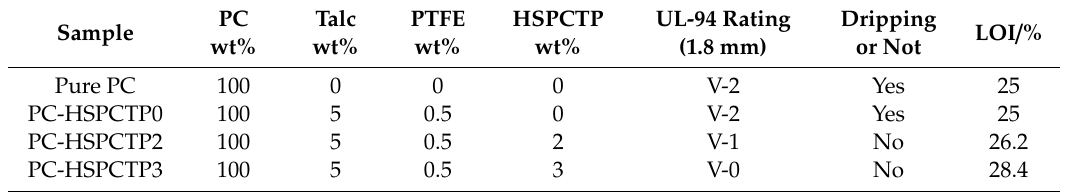
Table 2. Flame retardancy of the PC / HSPCTP